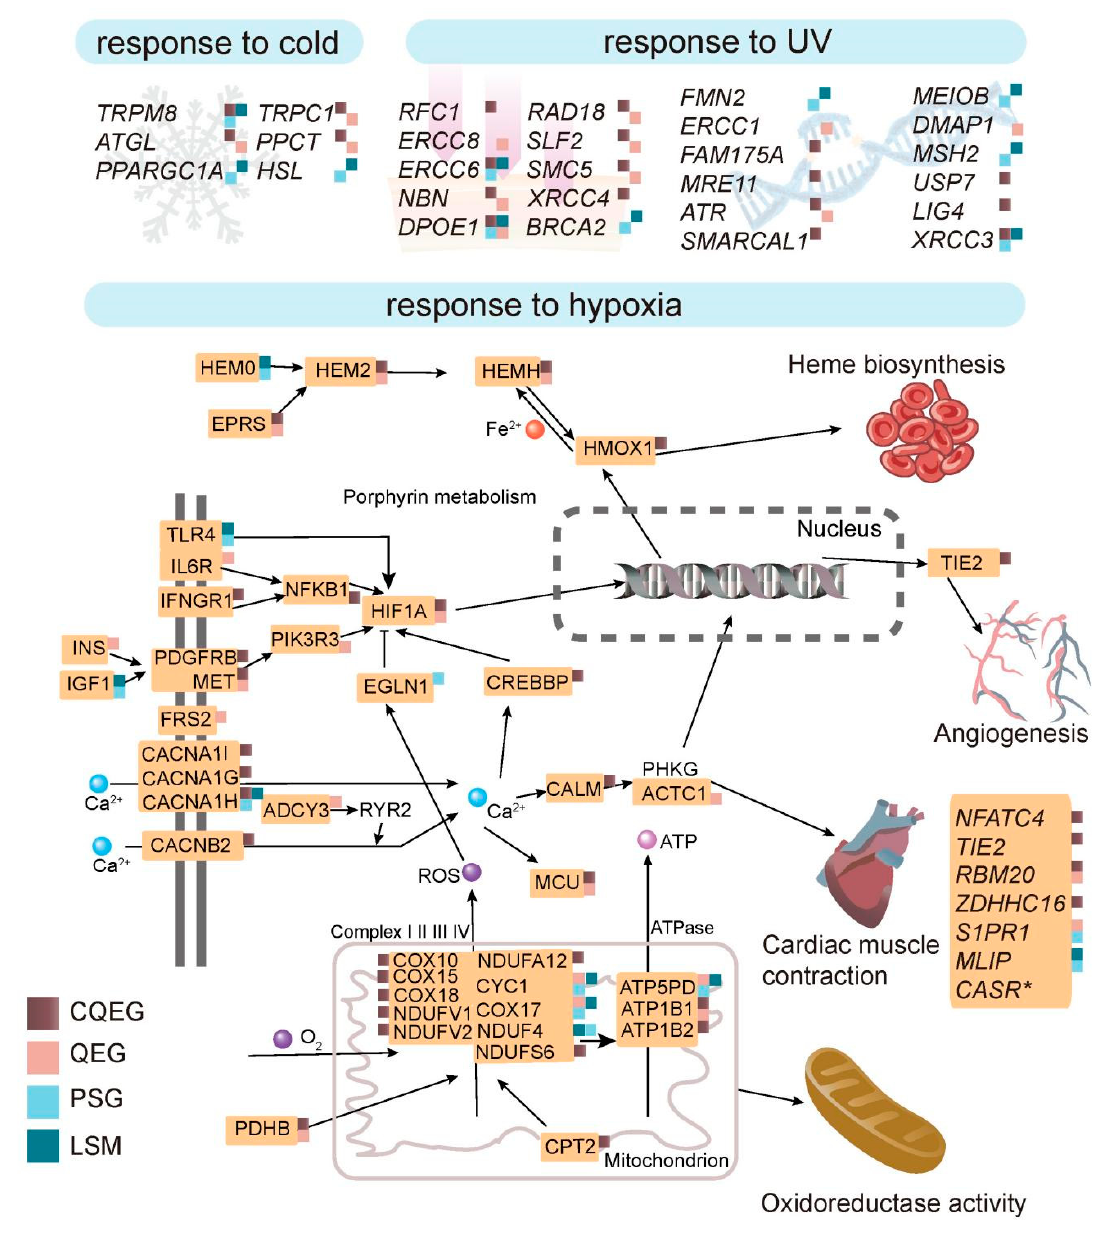
Figure 5. Genes and pathways associated with plateau animal adaptation to hypoxia, cold tempera- ture, and high UV radiation. Hypoxia-activated pathways that regulate erythropoiesis, cardiovascular development, and oxidative phosphorylation in plateau animals are depicted in detail. Different categories of genes, i.e., CQEGs, QEGs, PSGs, and genes with L. sacra -specific mutations (LSM) are indicated by squares with different colors. Expanded CASR in L. sacra is marked with an “*”.